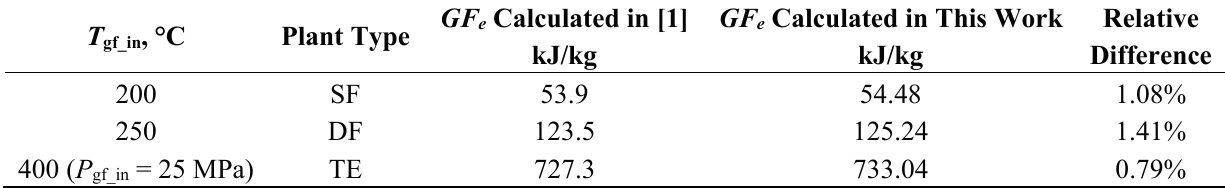
Table 5. Power plant simulation results validation of this work.